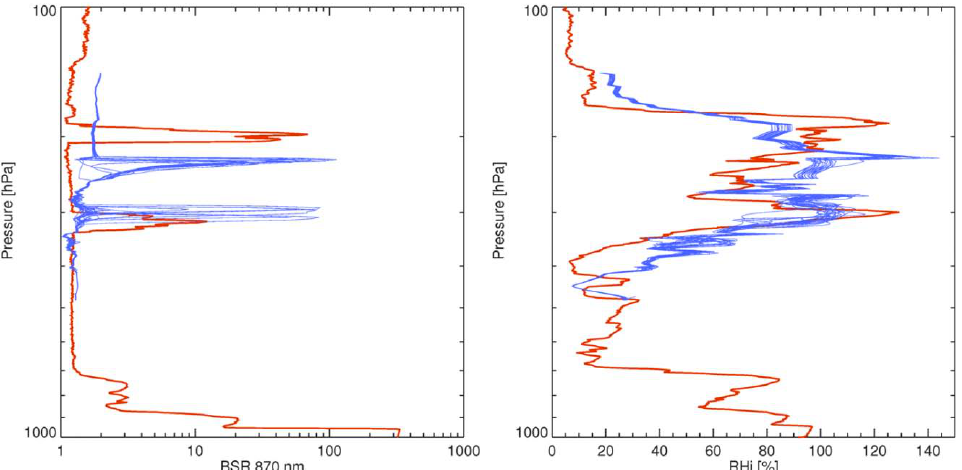
Fig. 6. Ensemble of 20 microphysical column model runs (blue) with superimposed small-scale fluctuations compared with the measurements (red). The left panel shows BSR 870 and the right RH ice